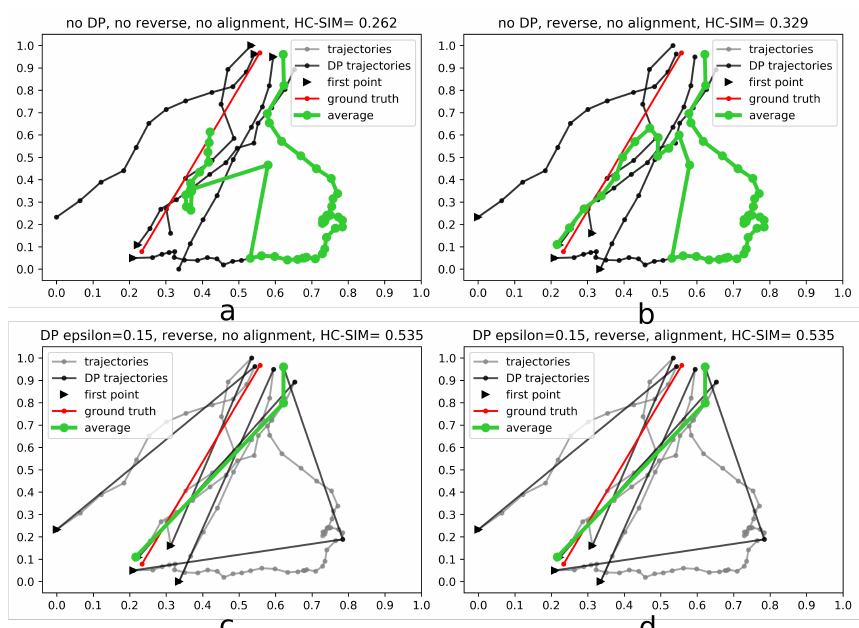
Figure A1. Algorithm applied to sample 9 with and without extensions. ( a ) No extensions just the averaging based on corresponding ids; ( b ) algorithm with reversion. The order of points in trajectory is reversed in order to group all starting points at one side; ( c ) algorithm with DP and (cid:101) set to 0.15; ( d ) algorithm including the alignment of the shorter paths.